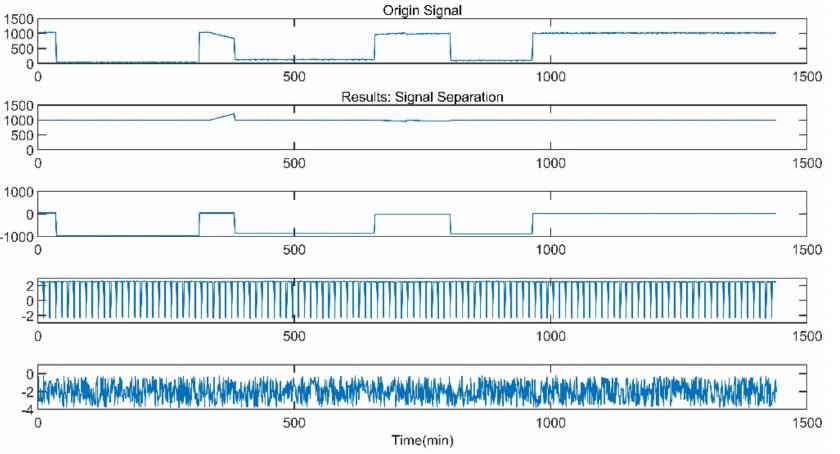
Figure 9. Separation Result of Catastrophic Failure.